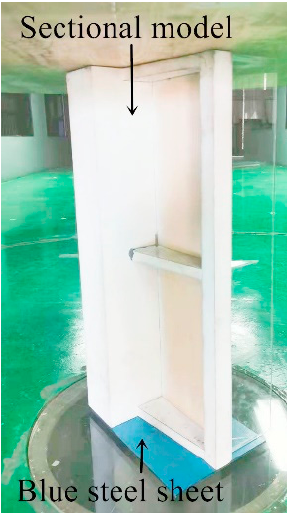
Figure 2. Sectional model in TK-400 wind tunnel laboratory.